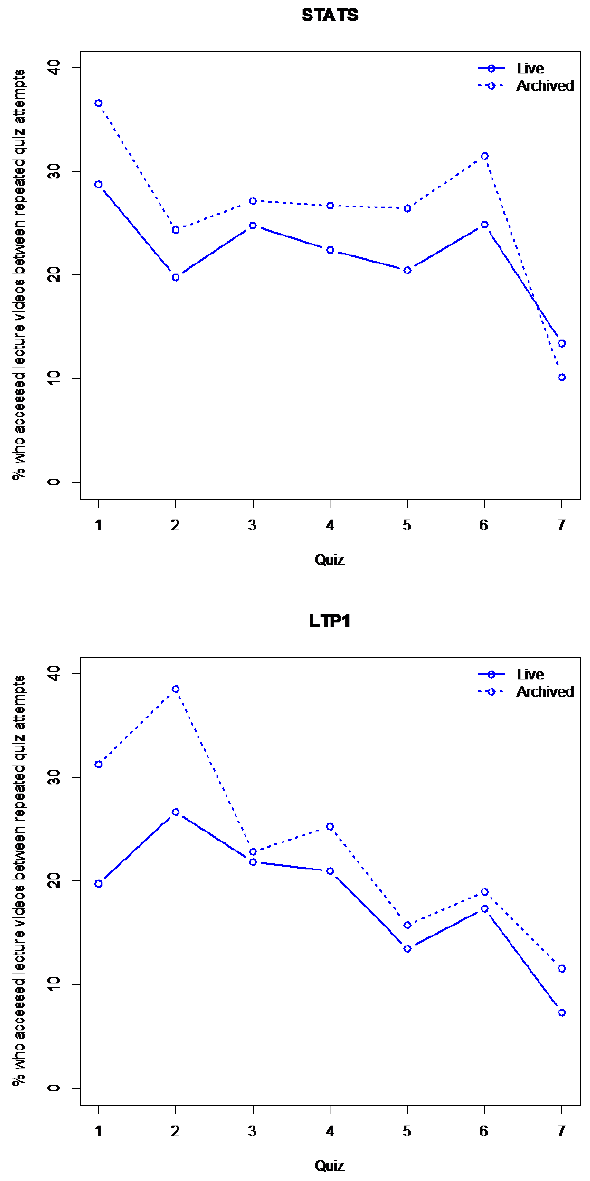
Figure 10. Percentage of learners who reattempted quizzes who accessed lecture videos between